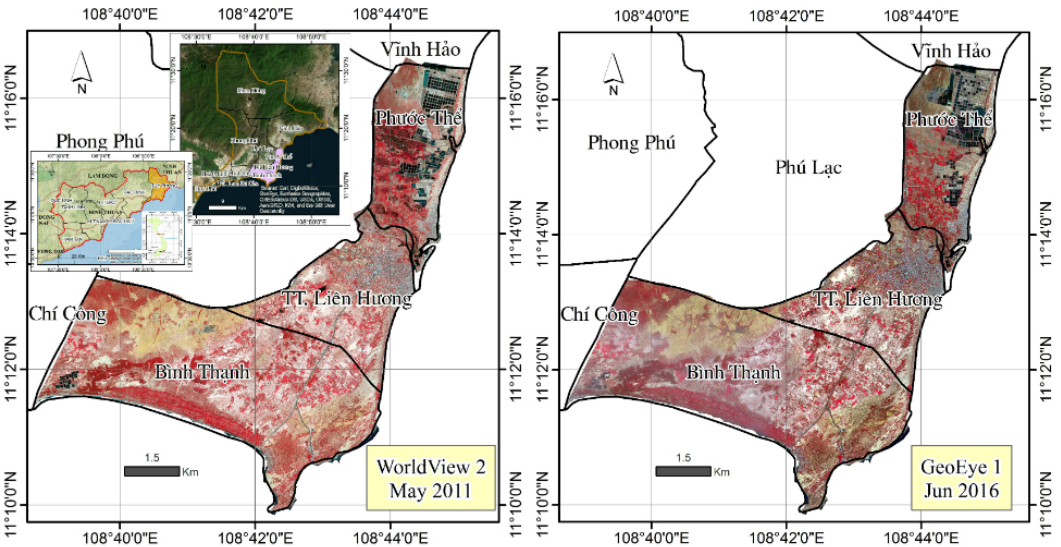
Figure 2. False color band combination for two-image datasets used for the research area: the 2011 WorldView2 (NIR2, R, G as R,G,B), and the 2016 GeoEye1 (NIR, R, G as R,G,B). See Table 1 for the sensor-specific band number designations along with